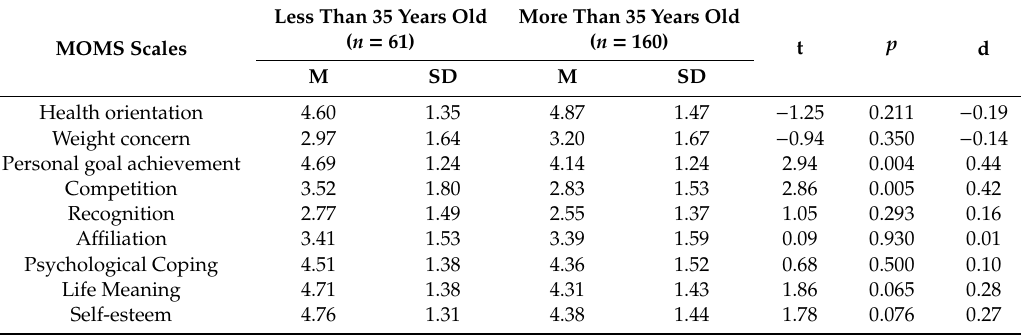
Table 4. Motivations of runners in marriage / relationship aged under 35 and over